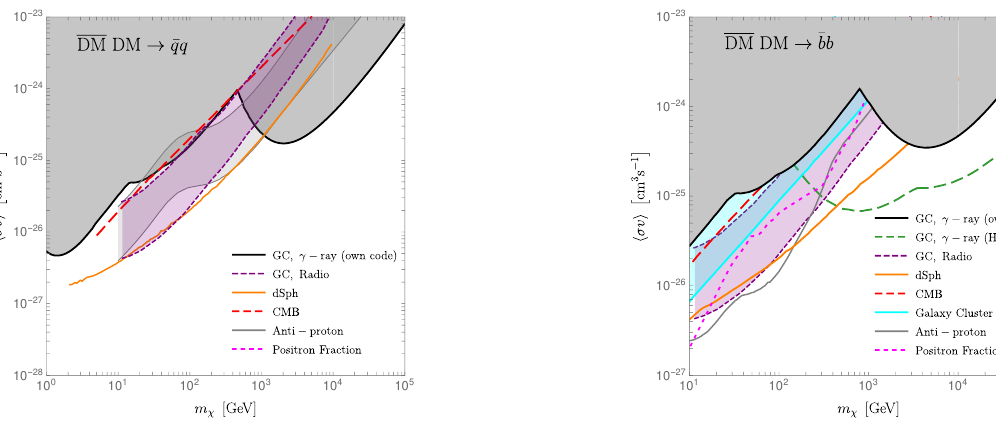
Figure 8 . The constraints on for q = u ; d ; s (left) and q = b (right) which is representative (cid:27)v h i (cid:22) qq of q = c ; t for m . The constraints are taken from many di(cid:11)erent sources (DSph, galactic (cid:31) > m c;t centre, clusters) and targets (gamma rays, radio waves, positron,